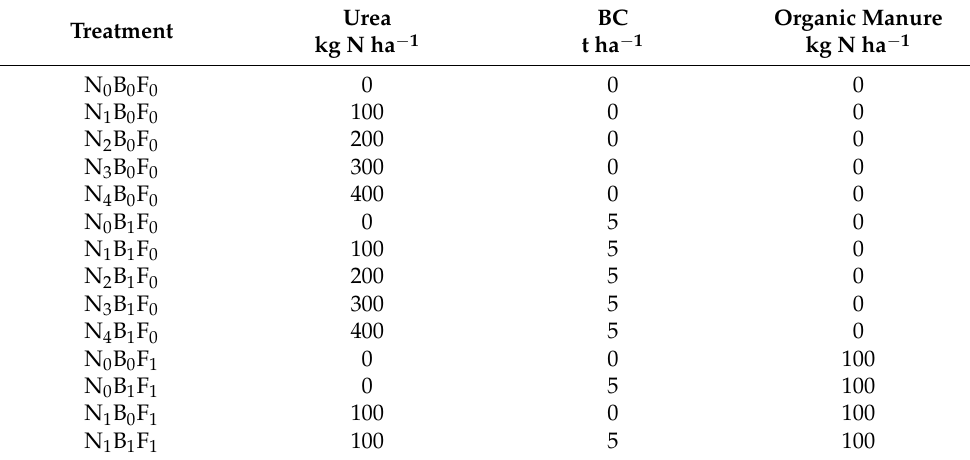
Table 2. Experimental treatment design.